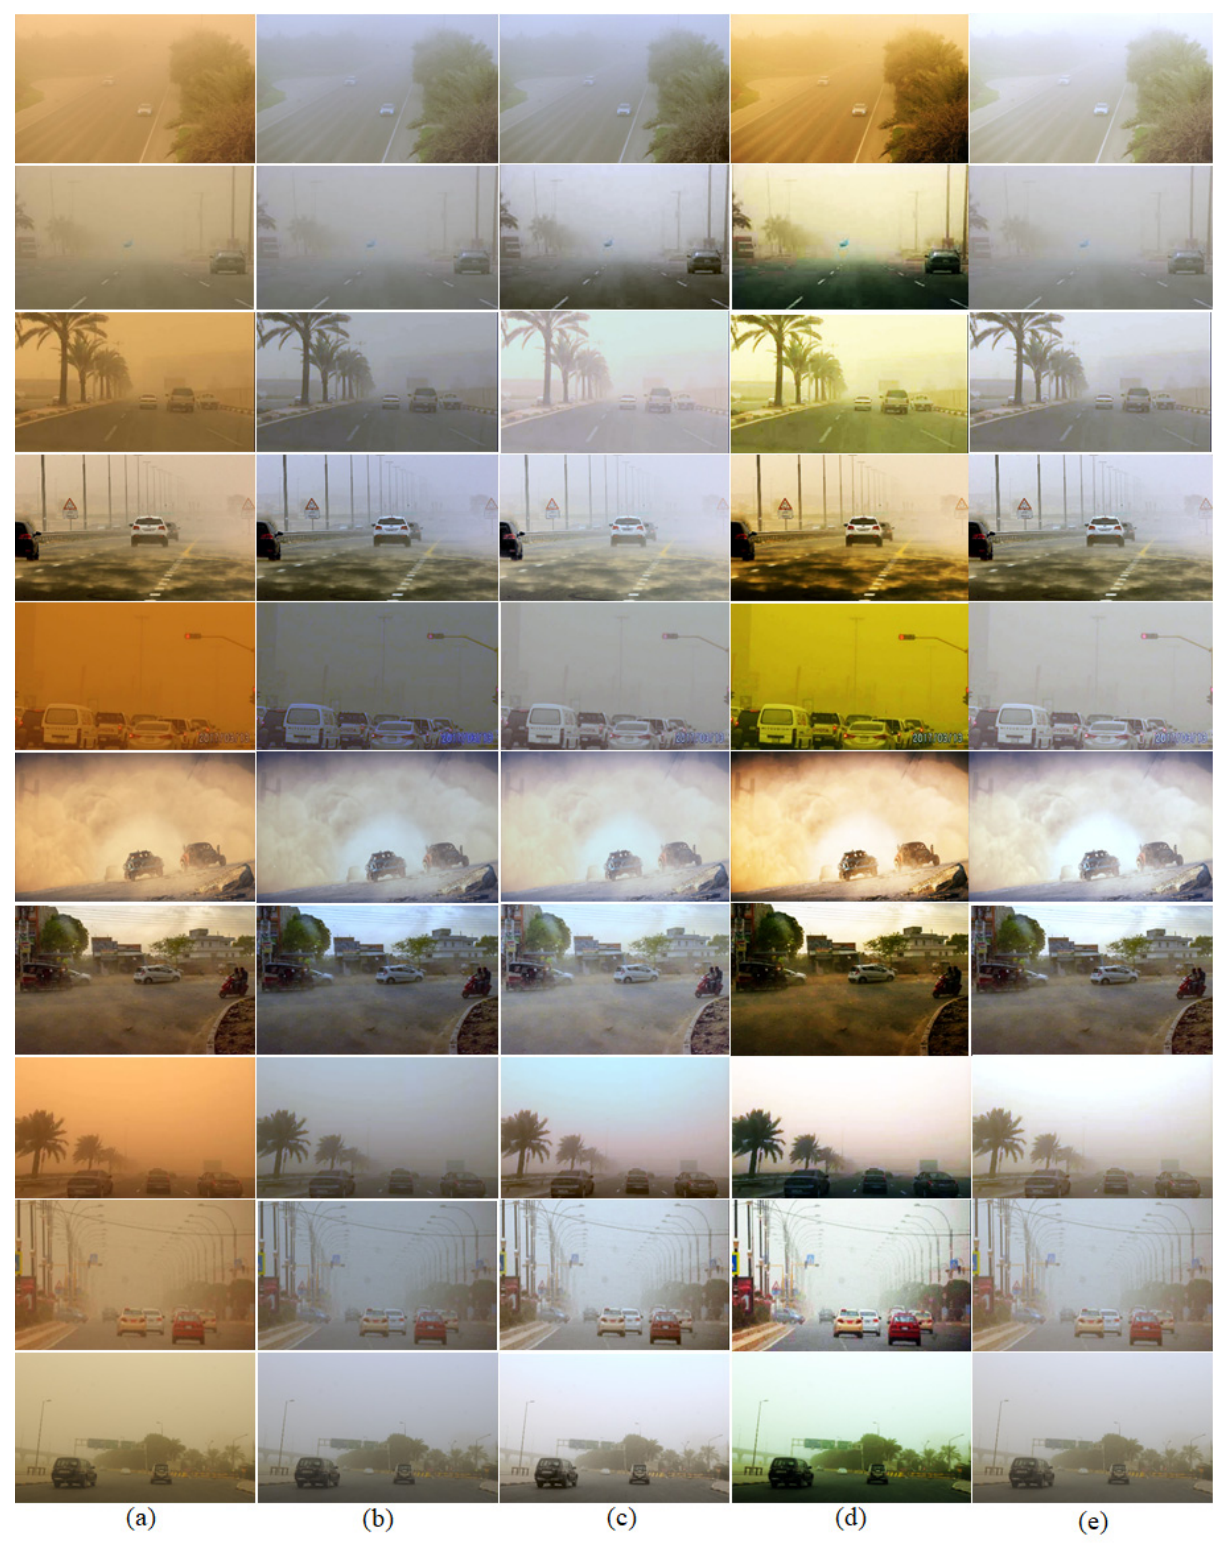
Figure 4. The comparison with state-of-the-art color correction methods and the proposed method: